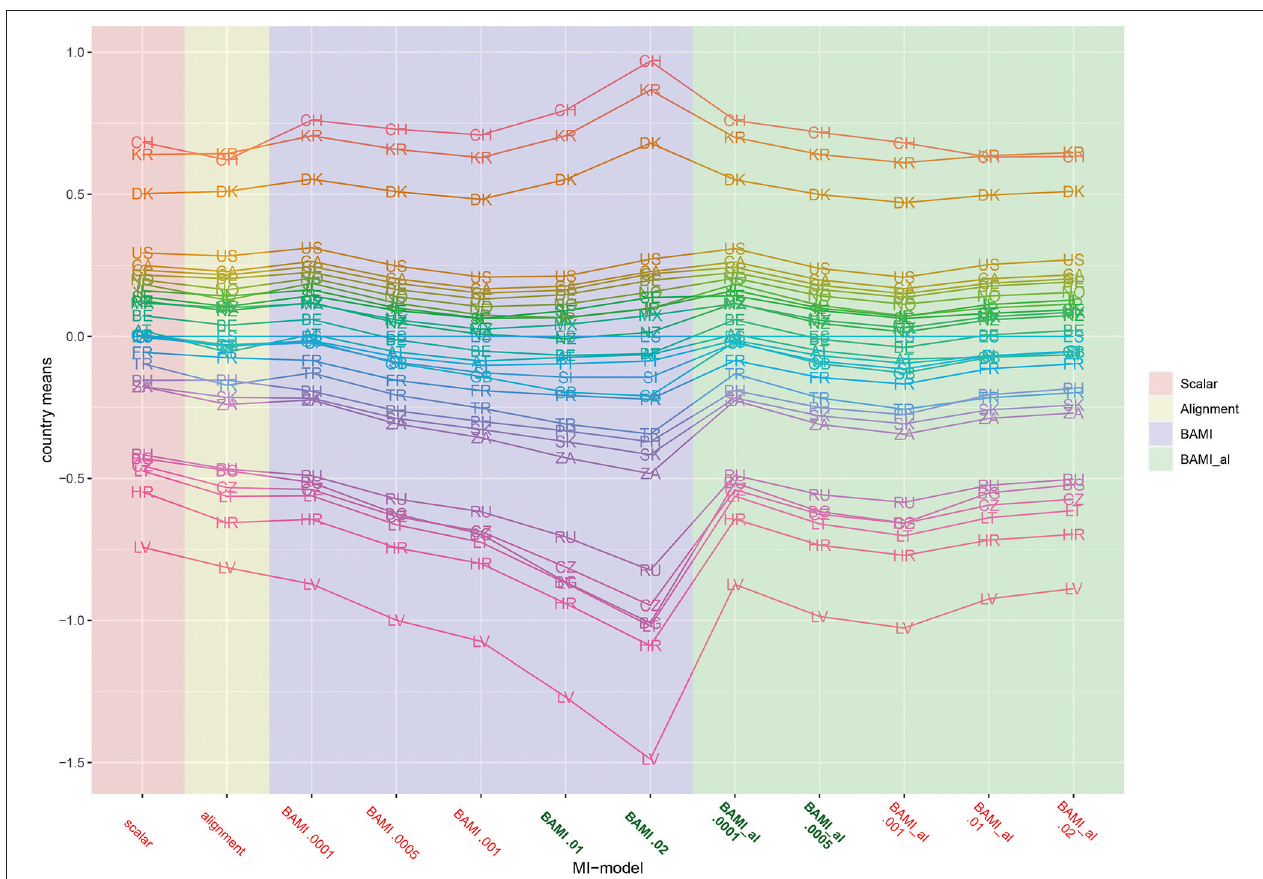
FIGURE 2 | Means per country for scalar invariance, ML alignment, and BAMI models with and without alignment. AT, Austria; BE, Belgium; BG, Bulgaria; CA, Canada; CL, Chile; HR, Croatia; CZ, Czech Republic; DK, Denmark; FI, Finland; FR, France; DE, Germany; GB, Great Britain; IL, Israel; JP, Japan; LV, Latvia; LT, Lithuania; MX, Mexico; NZ, New Zealand; NO, Norway; PH, Philippines; RU, Russia; SK, Slovakia; SI, Slovenia; ZA, South Africa; KR, South Korea; ES, Spain; SE, Sweden; CH, Switzerland; TR, Turkey; US, United States. The x-axis shows the different models—scalar, ML alignment, and BAMI with and without alignment—with their specific variances. Models that appear to ba a good fit to the data are indicated in bold green, models with bad fit in red.